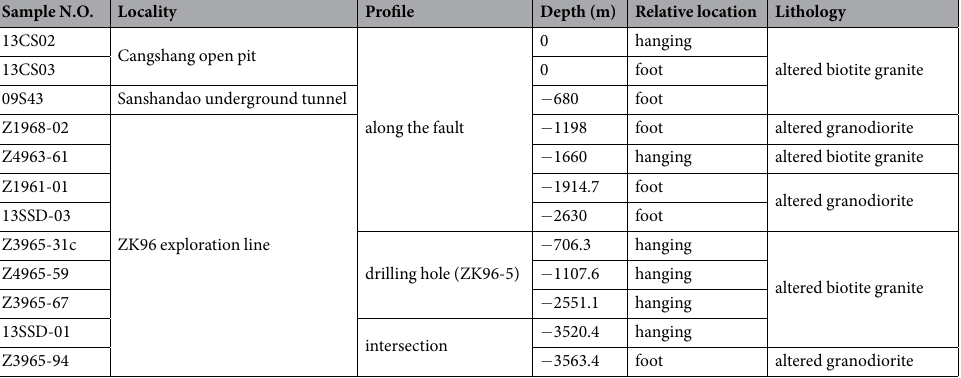
Table 1. A summary of sampling locality, depth and